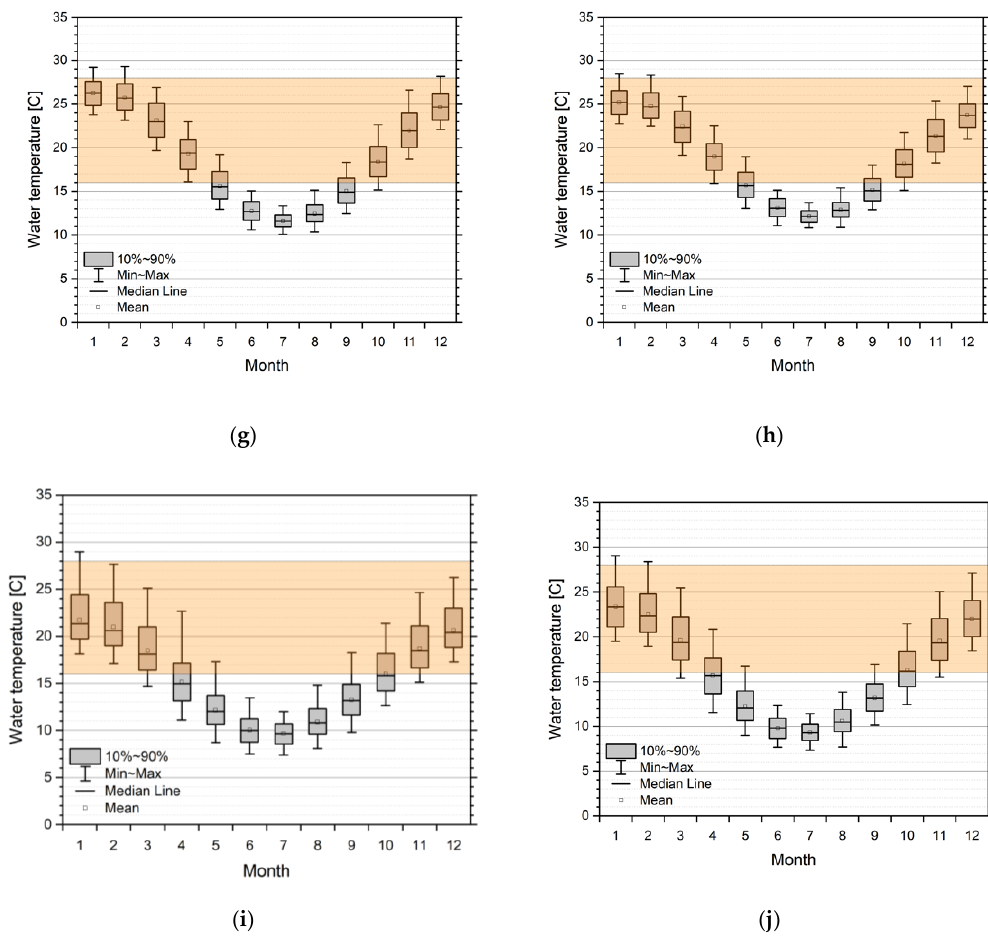
Figure 6. Monthly statistics of simulated water temperatures from 1990 to 2015/2018 in the five catchments from north to south. Overlay is a suggestive orange band of permissive temperatures (16–28 °C) for virus activity. ( a ) Moonie station (417204A Fenton). Lachlan stations; ( b ) Upper river section, station 412067 d/s Lake Wyangala; ( c ) Mid-river section, station 412038 Willandra; ( d ) Lower river section, station 412194 4_Mile. Mid-Murray stations; ( e ) Upper river section, station 409025 Yarrawonga; ( f ) Lower river section, station 409207 Torrumbarry. Lower Murray stations; ( g ) Upper river section, station 4260501 Lock 9; ( h ) Lower river section, station 4260902 Lock 1. Glenelg stations;